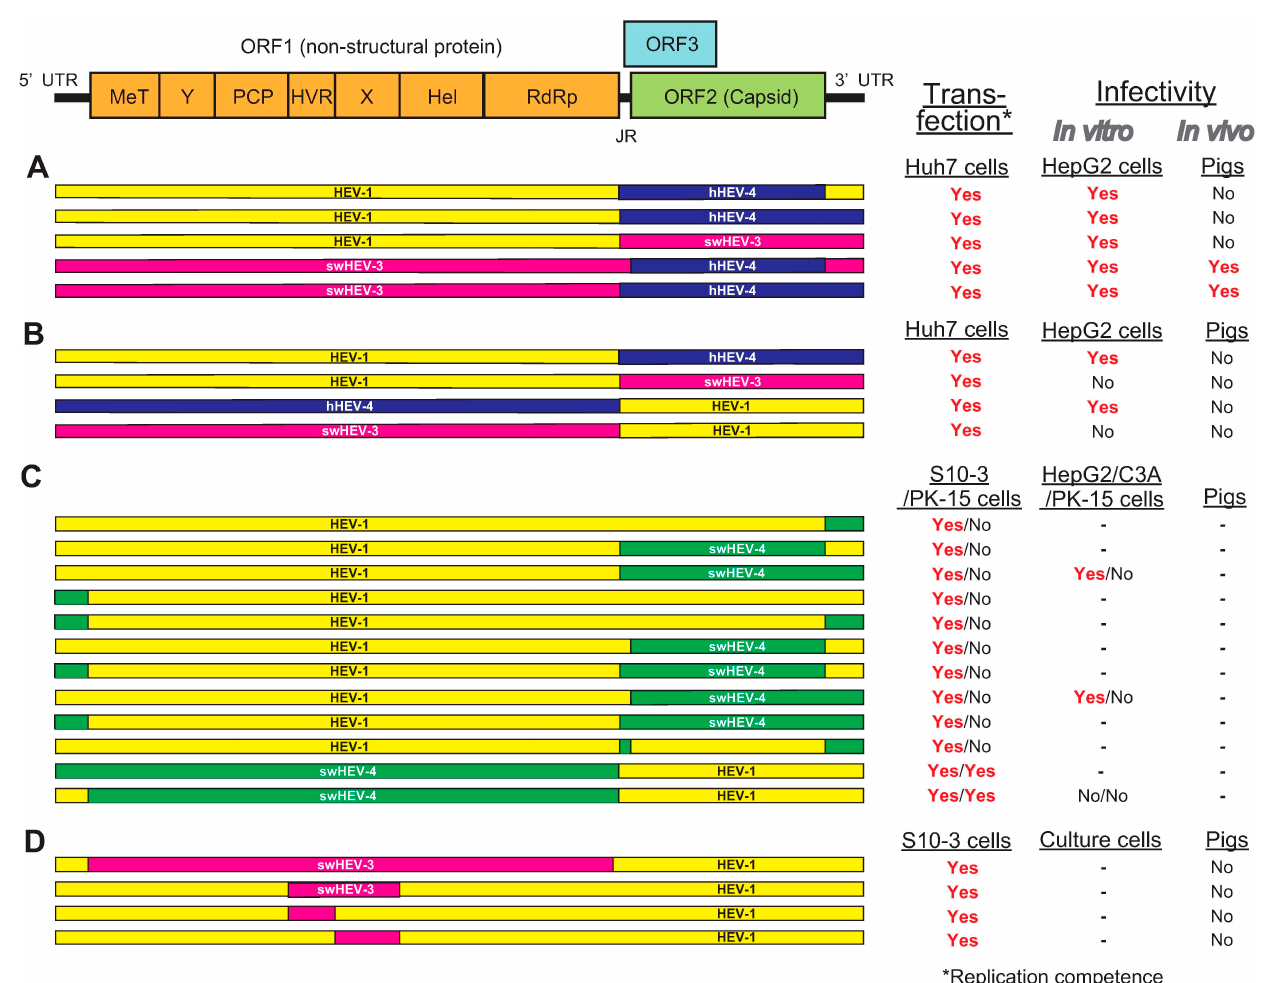
Figure 2. A schematic diagram of the genomic organization of HEV and its intergenotypic chimeric constructs summarized from four relevant papers. ( A ) Intergenotypic chimeric viruses where the ORF2 capsid gene—either alone or in combination— was swapped with its adjacent JR and 3 ′ UTR, between HEV-1 and human HEV-4, swine HEV-3 and human HEV-4, and HEV-1 and swine HEV-3 [111]. ( B ) Intergenotypic chimeric viruses where the ORF2 gene along with its JR, ORF3, and 3 ′ UTR were swapped between HEV-1 and human HEV-4, and between HEV-1 and swine HEV-3 [161]. ( C ) Twelve different HEV-1–swine HEV-4 intergenotypic chimeric viruses with HEV-1 as the backbone where ORF2, ORF3, ORF1, or UTRs were replaced by corresponding segments from swine HEV-4 [156]. ( D ) The genomic backbone of HEV-1 was used to construct a panel of intergenotypic chimeras in which the entire ORF1 gene or its functional domains were swapped with the corresponding regions from swine HEV-3 [168].